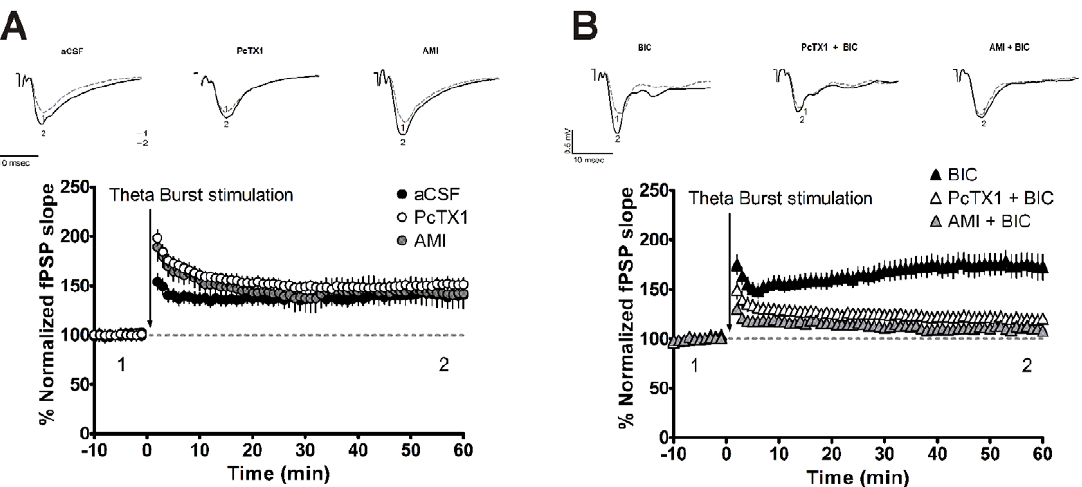
Figure 7. ASICs and GABA A receptors coordinate to regulate synaptic plasticity in CA1. A, robust LTP was elicited using a theta burst stimulation protocol (in aCSF condition, filled circles). This LTP was not affected by ASIC inhibition with amiloride (gray circles, 100 m M) or with PcTx1 (empty circles, 30 nM). B, simultaneous inhibition of GABA A receptors and ASICs impeded LTP. Blockade of GABA A with bicuculline markedly increased LTP (filled triangles). Co-application of bicuculline either with amiloride (gray triangles) or with PcTx1 (empty triangles) resulted in an attenuation of bicuculline-enhanced LTP (filled triangles). Overlays for A and B show representative responses before and after stimulation (top). Normalized slope of fPSP were shown in the bottom. Abbreviations: aCSF=artificial cerebral spinal fluid; AMI=amiloride; BIC=bicuculline; PcTx1=psalmotoxin 1.